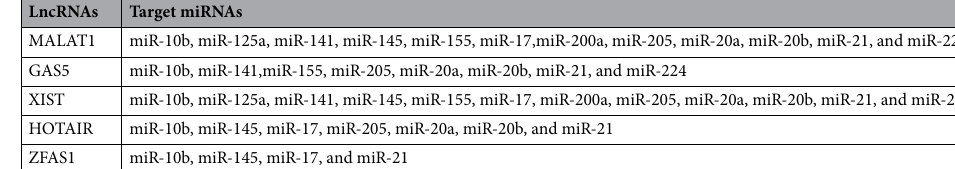
Table 5. Interaction analysis between selected miRs and lncRNAs in breast cancer